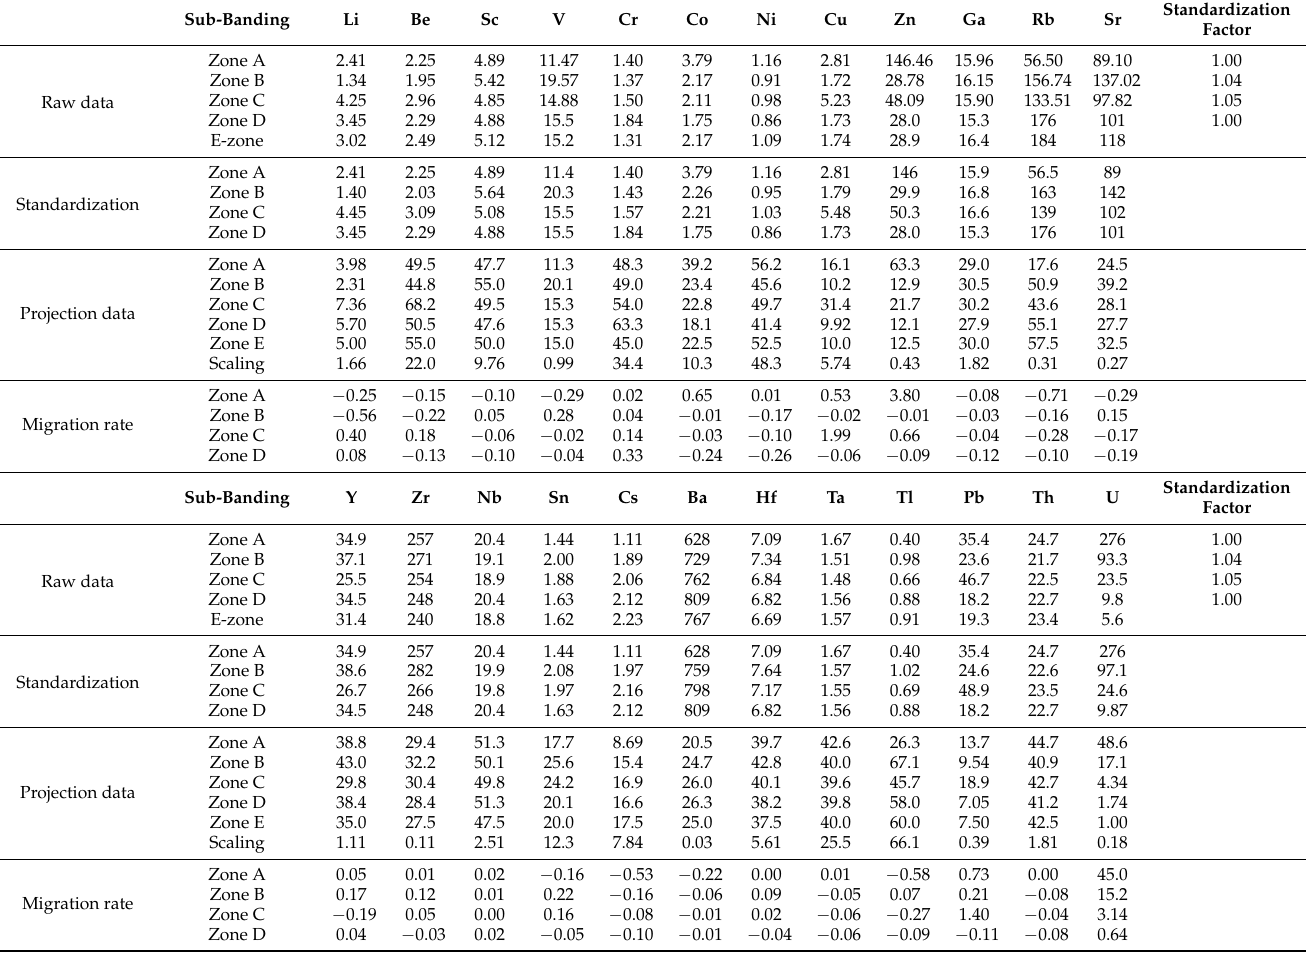
Table 2. Trace element content ( × 10 − 6 ) and data processing results of ore-fresh rock zoning rocks in the Zhangjiawu uranium deposit, Zhejiang Province, China.